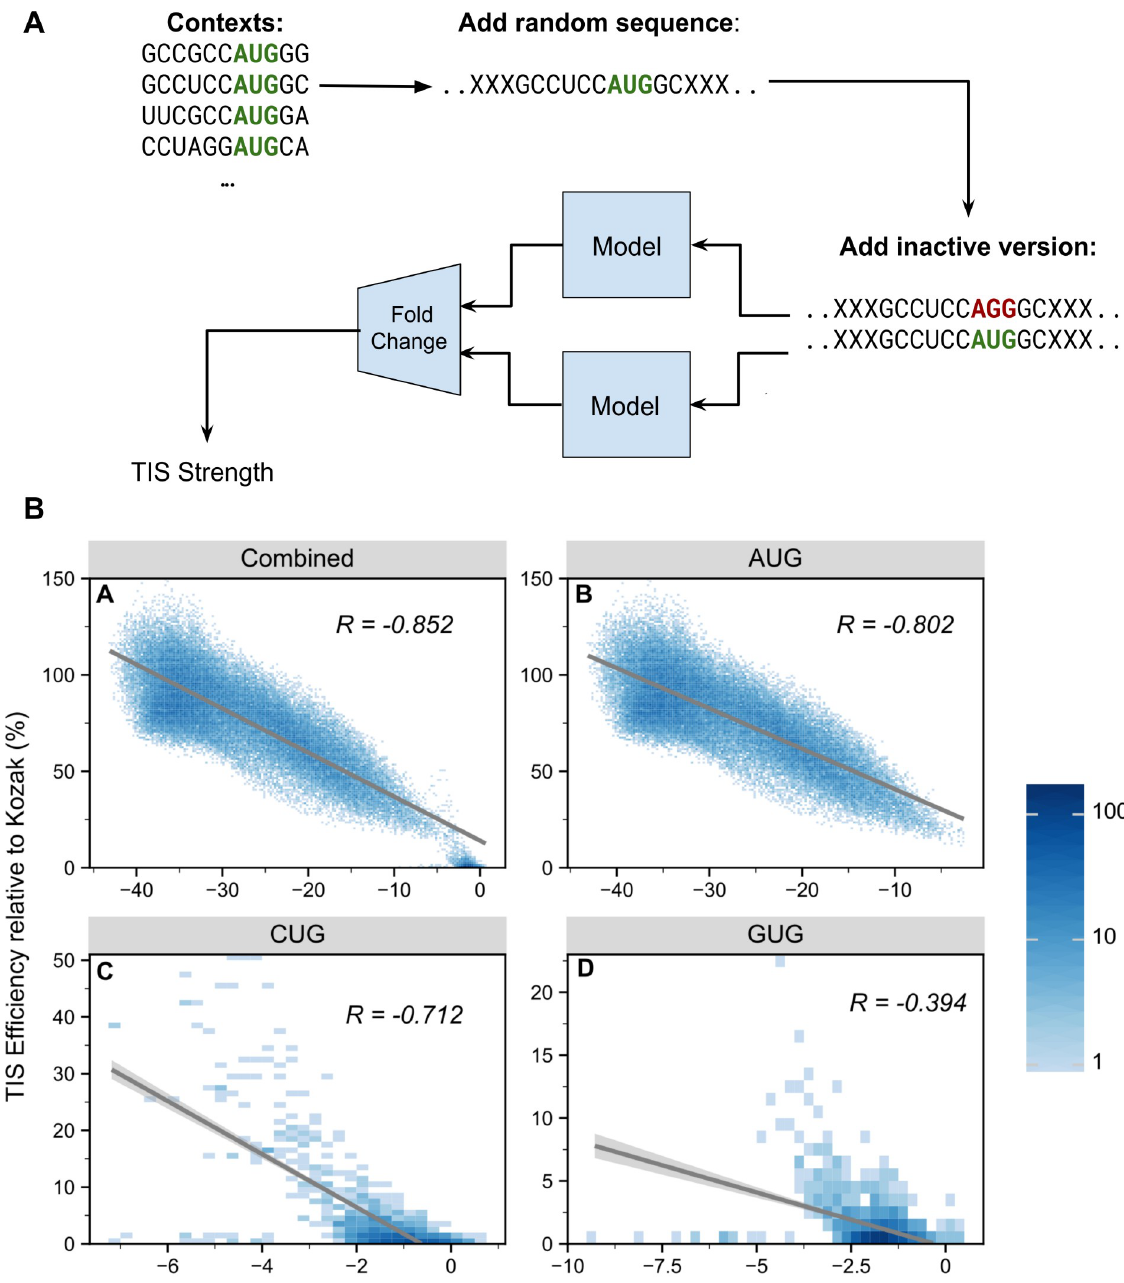
Fig 3. Framepool predicts the strength of upstream transcription initiation sites. A) The model was used to predict the effect of upstream TIS contexts by injecting them into random sequences and comparing predicted MRL fold change associated with upstream start codon activation (mutation AGG ! AUG). B) These predictions (x-axis) were correlated with independent experimental measurements of the relative strength of these contexts (y-axis). Overall, a negative correlation is observed (top right) as expected because upstream TISs compete with canonical TISs. For AUG start codon data [9], the model correlates well with the strength estimates (top right, Pearson correlation of -0.802), with more efficient contexts causing a larger predicted effect on MRL. Negative correlations were also observed for the alternative start codons CUG (bottom left) and GUG (bottom right) data [31]. The correlations are weaker, particularly for GUG, likely reflecting the difficulty of detecting more subtle motifs in MPRA data. Nevertheless, the model has still learned to distinguish between strong and weak CUG/GUG motifs to some